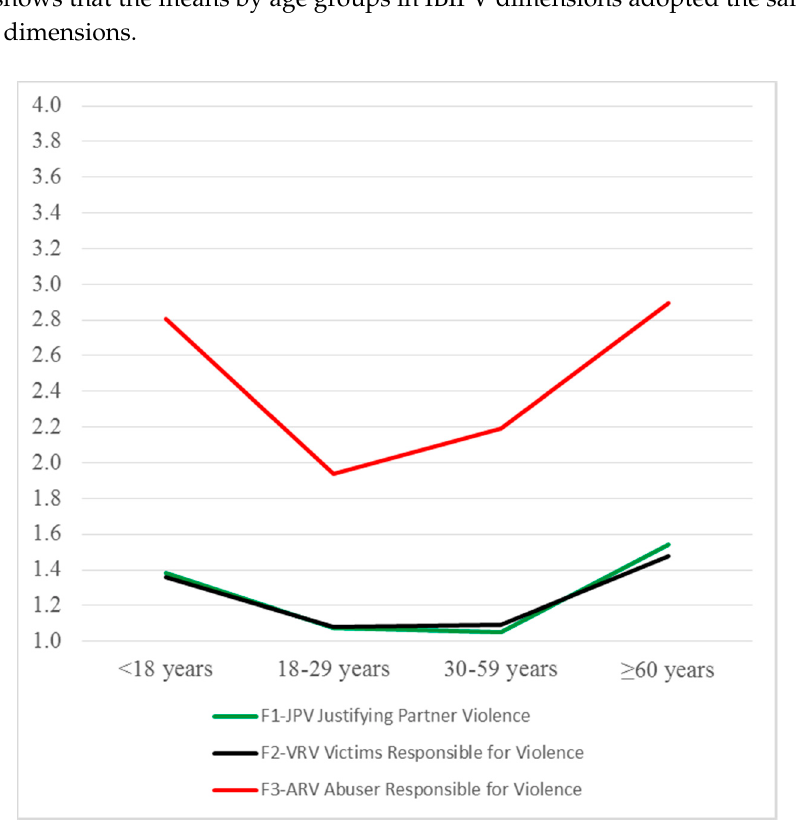
1 Set 1 = lower acceptance of IPVAW; Set 2 = higher acceptance of IPVAW.